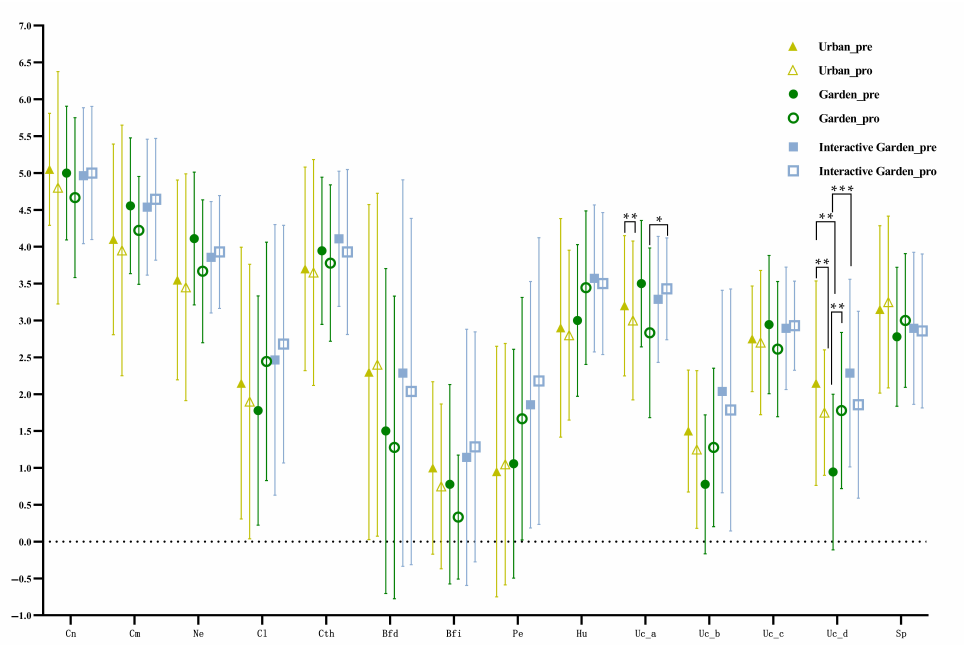
Figure 6. Descriptive statistical results of TCT-DP dimension score of the pre- and post-test. Note: * represents p < 0.05, ** represents p < 0.01, and *** represents p < 0.001. 1: Continuations (Cn); 2: completion (Cm); 3: new elements (Ne); 4: connections made with a line (Cl); 5: connections made to produce a theme (Cth); 6: boundary breaking that is fragment-dependent (Bfd); 7: boundary breaking that is fragment-independent (Bfi); 8: perspective (Pe); 9: humor and affectivity (Hu); 10: unconventionality, a (Uc_a); 11: unconventionality, b (Uc_b); 12: unconventionality, c (Uc_c); 13: unconventionality, d (Uc_d); 14: speed